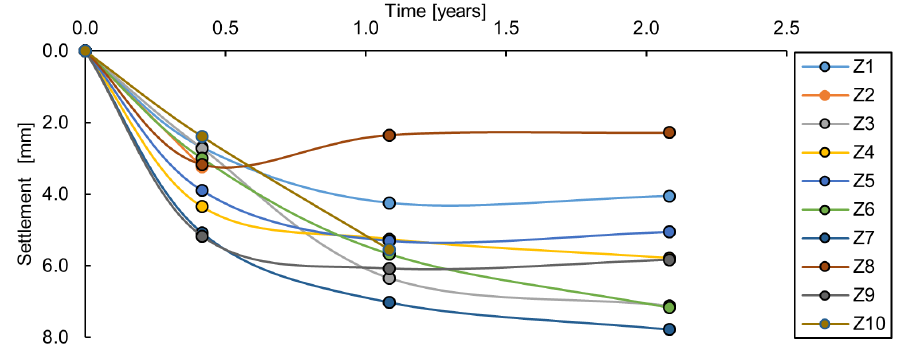
Figure 9. The course of settlement of benchmarks over time.